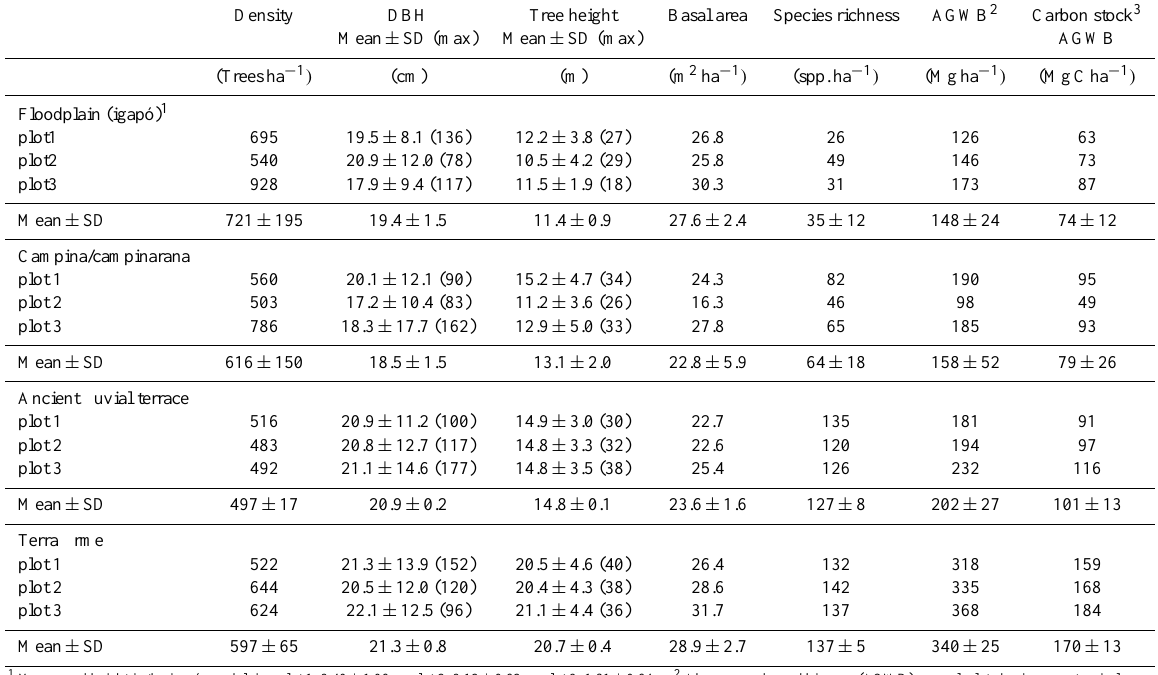
Table 3. Tree species richness, forest structure, above-ground wood biomass (AGWB) and carbon stocks of the inventoried forest plots. Density DBH Tree height